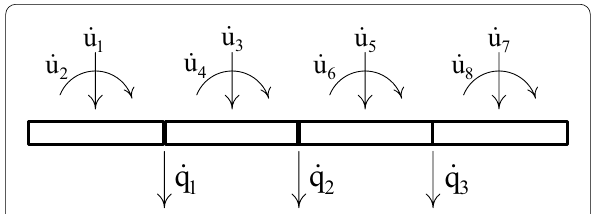
Fig. 3 Centroidal velocities in a continuous mass system.